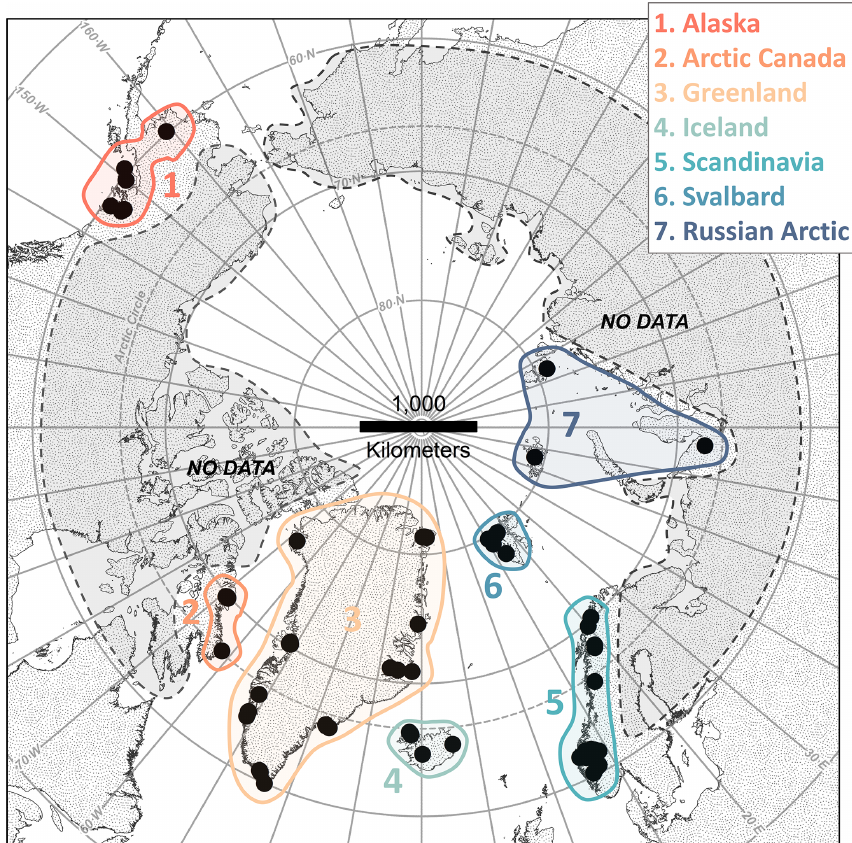
Figure 1. Map of Holocene lake-based GIC records used in this study. From west to east are 1. Alaska ( n = 6), 2. Arctic Canada (Baffin Island, northeastern Canada; n = 5), 3. Greenland ( n = 22), 4. Iceland ( n = 5), 5. Scandinavia ( n = 20), 6. Svalbard ( n = 6), and 7. the Russian Arctic ( n = 2, plus one non-lake record). Gray polygons show areas with no lake-based GIC records. For a list of included studies, see Table S1 in the